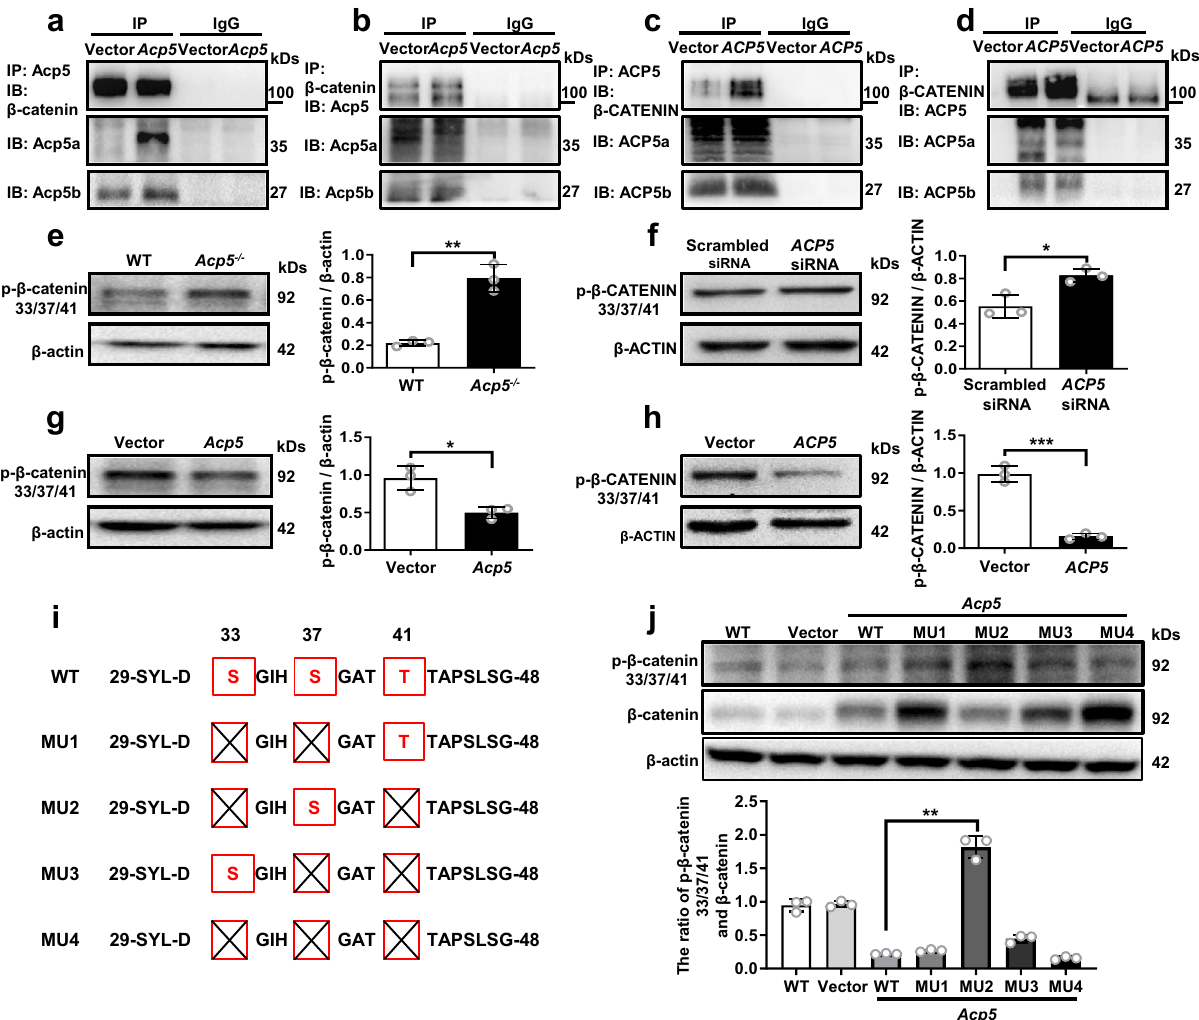
Fig. 5 Acp5 dephosphorylates β -catenin at Ser33 and Thr41. a – d Coimmunoprecipitation of Acp5 and β -catenin in PMLFs ( a , b ) and in PHMLs ( c , d ). e – h Western blot analysis of the levels of p- β -catenin (S33, S37 and T41) in WT and Acp5 − / − PMLFs ( e , p = 0.0013), ACP5 siRNA and Scrambled siRNA treated PHLFs ( f , p = 0.0159), Acp5 -plasmid and Vector treated Acp5 − / − PMLFs ( g , p = 0.0188) and Acp5 -plasmid and Vector treated PHLFs ( h , p = 0.0003). i The schematic results showing the mutant plasmids (MU1-3) of these three phosphorylated sites. Each of mutant plasmids (MU1-3) of these three phosphorylated sites maintained one normal site and two mutant sites (red boxes), and all phosphorylated sites were deleted in MU4. j Western blot analysis of the levels of β -catenin and p- β -catenin (S33, S37 and T41) in PMLFs following plasmids transduced ( p = 0.0036). The data are represented as the mean ± SEM of three independent experiments. Two-sided Student ’ s t -test ( a – i ) and two-sided unpaired Student ’ s t -test with Welch ’ s correction (j) were applied. * p < 0.05; ** p < 0.01; *** p < 0.001. Source data are provided as a Source Data fi catenin phosphorylated at Ser33, Ser37 and Thr41 in Acp5 − / − PMLFs (Fig. 5e) and ACP5 -silenced PHLFs (Fig. 5f) than in WT PMLFs and Scrambled RNA-transfected PHLFs, respectively. In contrast, the opposite was observed in ACP5 -overexpressing fi broblasts (Fig. 5g, h), indicating that Acp5 appears to dephosphorylate the Ser33, Ser37 and Thr41 sites in p- β - catenin, by which it inhibits the process of degradation. To further con fi rm the exact sites for Acp5 dephosphorylation, we constructed 4 plasmids containing mutated β -catenin (MU1, MU2, MU3 and MU4) (Fig. 5i) and transfected the mutant β - catenin- plasmids and Acp5 -plasmid into PMLFs, followed by TGF- β 1 stimulation. Interestingly, low ratio of p- β -catenin (33/ 37/41) and β -catenin were noted in PMLFs transfected MU plasmids except for MU2 (Fig. 5j), suggesting that Acp5 speci fi cally dephosphorylates the Ser33 and Thr41 sites on p- β - catenin and inhibits the degradation of β -catenin.